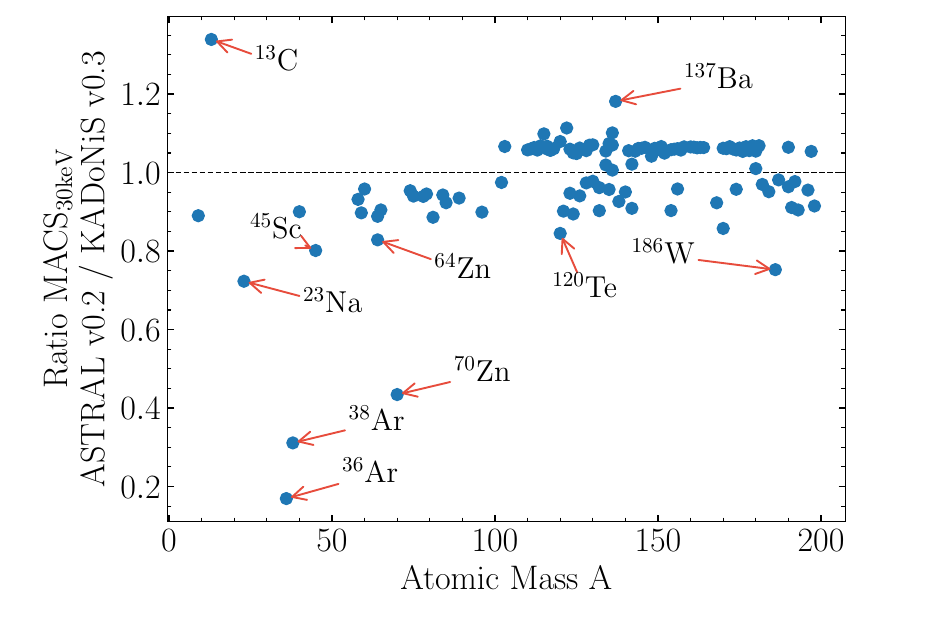
Figure 3. Comparison of MACS at kT = 30 keV from the present ASTRAL v0.2 and the KADoNiS v0.3 compilation